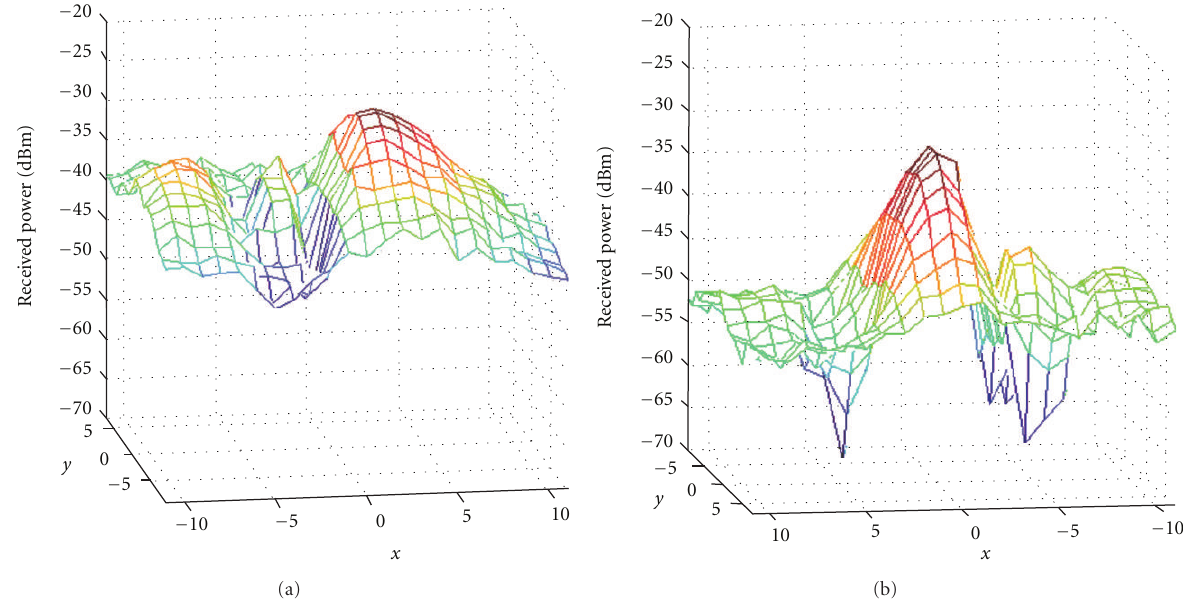
Figure 10: Distribution of proximity field (a) no shielding sheets, (b) sheets on and beneath the